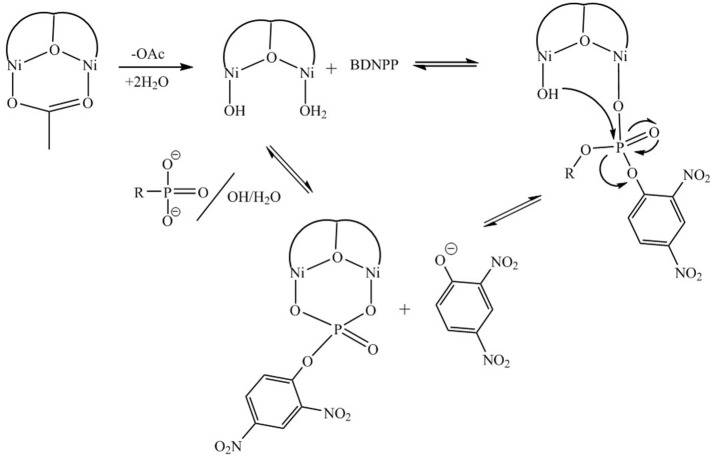
Proposed mechanism of reaction between [Ni2(L1)(μ-OAc)(H2O)2]2+ and BDNPP− adapted from (Vichard and Kaden, 2004). The proposed mechanism resembles that of the lower pH mechanism proposed by Massoud et al. (2016).